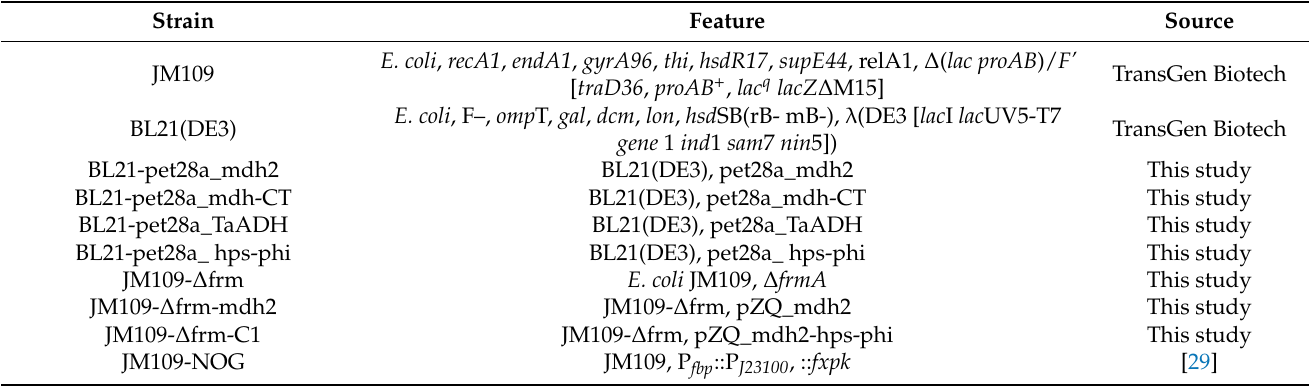
Table 2. Strains used in this study. The first column reports the strains constructed in this study, the second column demonstrates the characteristics of the strains, and the third column shows the sources of these